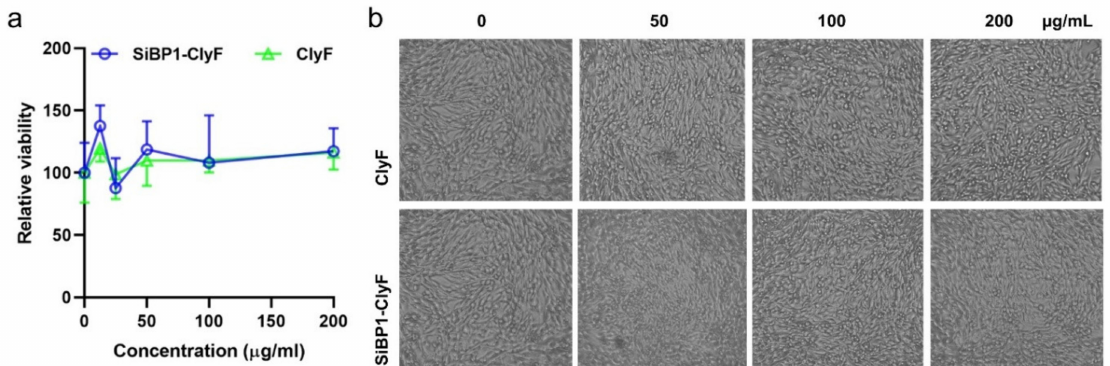
Figure 7. SiBP1-ClyF-immobilized surfaces support normal growth of mammalian cells. Wells were immobilized with various concentrations (0, 12.5, 25, 50, 100, and 200 µ g/mL) of SiBP1-ClyF or ClyF overnight at 4 ◦ C and inoculated with 104 cells/well of BHK-21 cells for 24 h, the cell viability of each treatment was then determined by CCK-8 assay ( a ) and the cell confluence of each treatment was captured by microscopy ( b ). Representative images under 10 × objective lens from wells immobilized with 0, 50, 100, and 200 µ g/mL SiBP1-ClyF or ClyF were